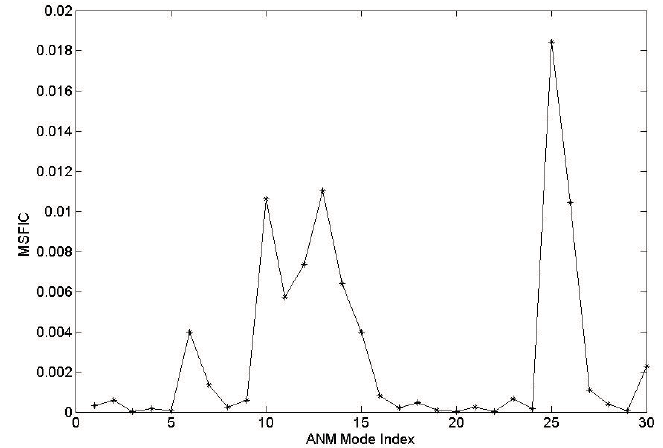
Figure 2. The calculated mean-square fluctuation of the internal coordinate (MSFIC) values for the first 30 slowest ANM modes. From this figure, it is found that the MSFIC values for modes 10, 13, 25 and 26 are relatively